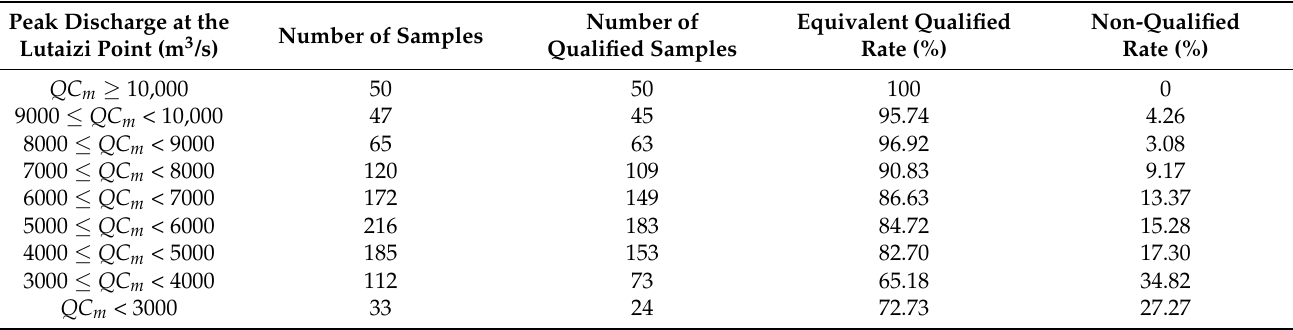
Table 2. Equivalent Qualified rate in Flood of Different